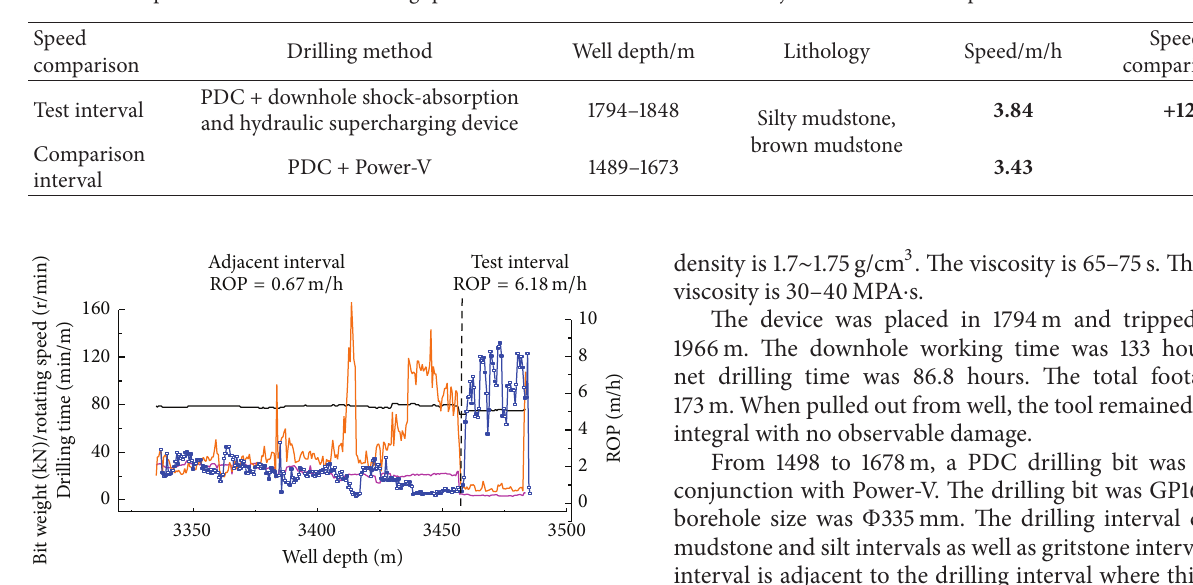
Table 2: Comparison of mechanical drilling speeds into siltstone and mudstone in adjacent well intervals speeds into siltstone and mudstone.